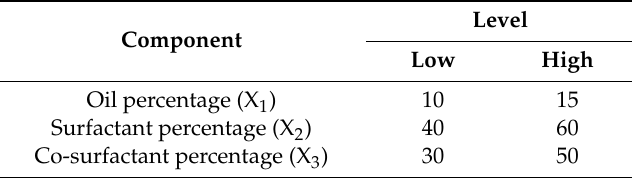
Table 1. Components of the mixture design and their selected